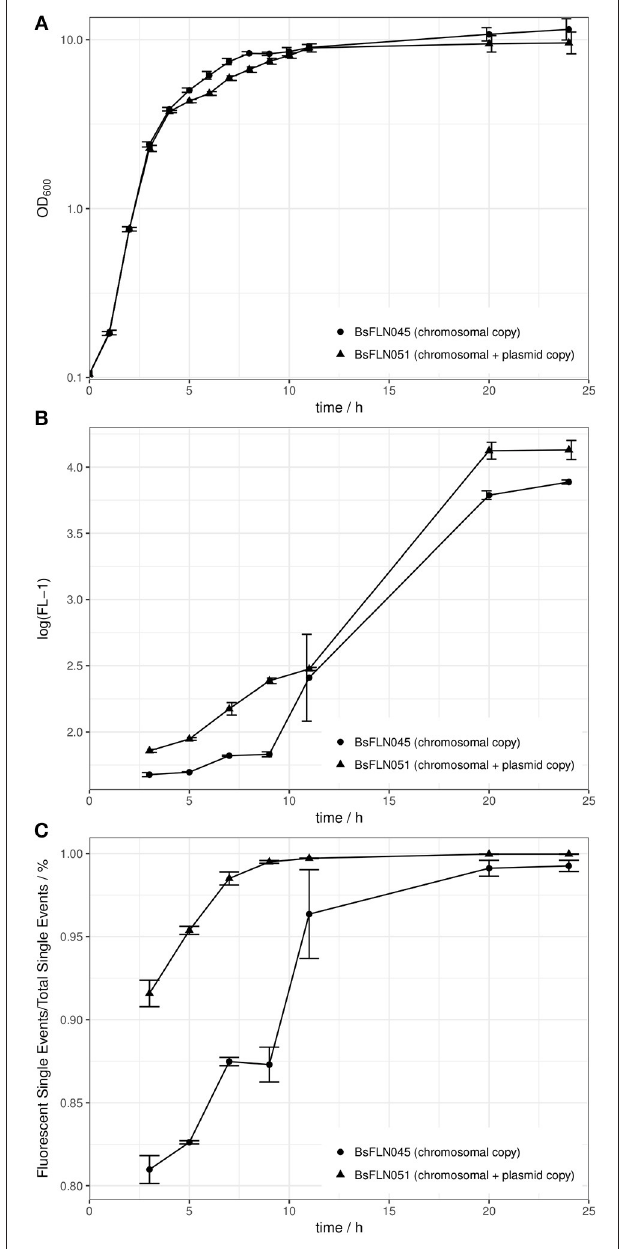
FIGURE 2 | (A) Averaged growth curves of strains BsFLN045 (chromosomal copy) and BsFLN051 (chromosomal + plasmid copy); (B) Logarithmic plot of increase in FL-1 fluorescence and assumed intracellular GFP content over cultivation time. For all points except at t = 11h, the increased fluorescence of BsFLN051 is statistically significant (Student’s t -test, alpha = 0.05). (C) Increase in the share of gfp -expressing cells over cultivation time. For all points except at t = 11h the increased fluorescence of BsFLN051 is statistically significant (Student’s t -test, alpha = 0.05). Plotted values are averages of n = 4 biological replicates with error bars showing standard